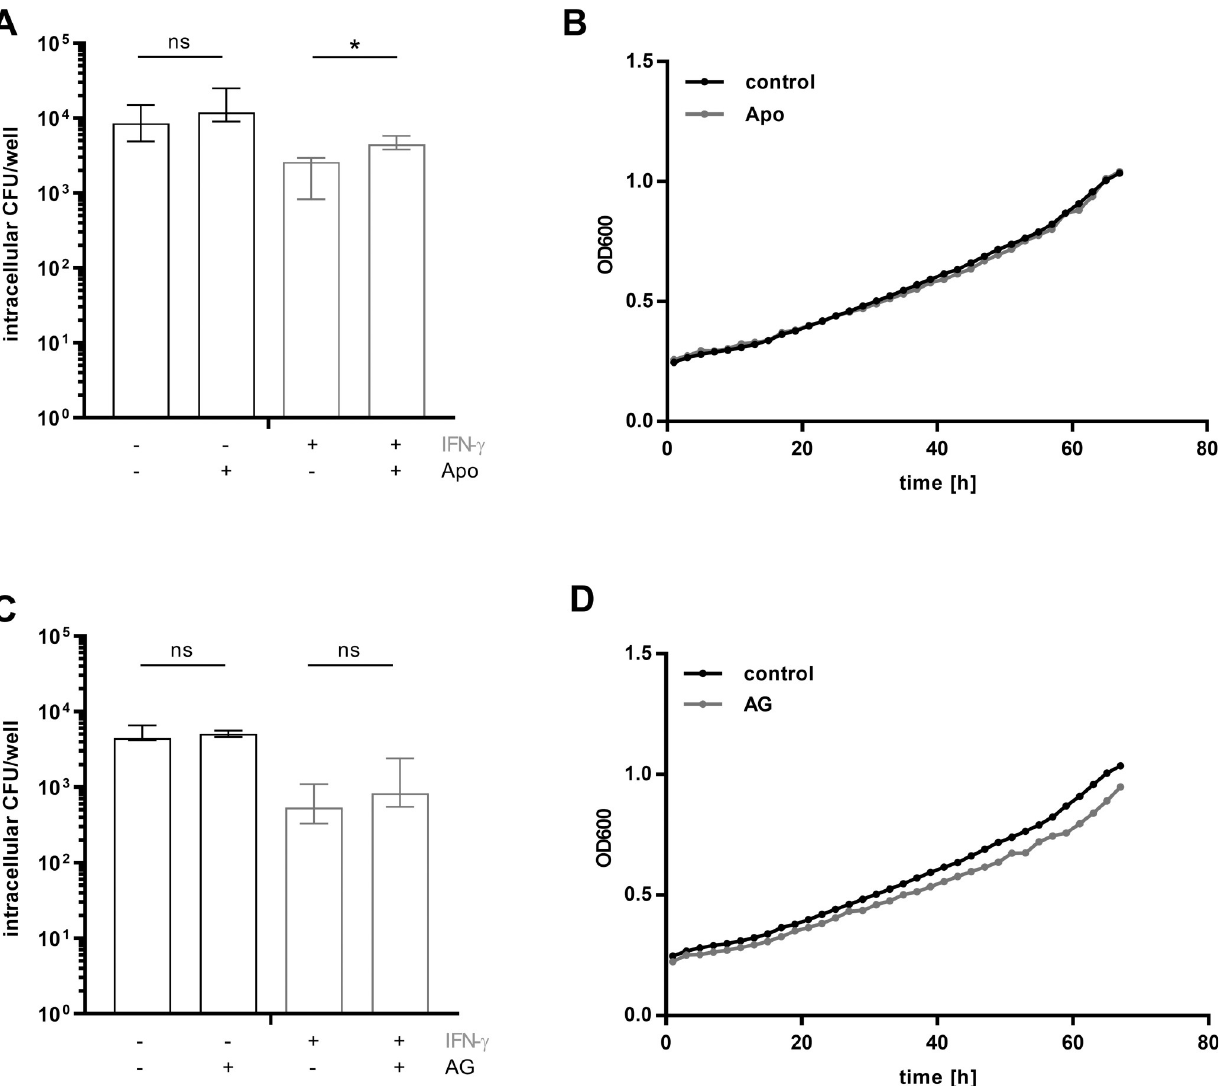
Fig 5. The antimicrobial effect of IFN- γ is mediated by the production of ROS. hMDMs were incubated with 500 μ M IFN- γ and inhibitors of inducible NADPH oxidase (apocynin) (A) or nitric oxide synthase (aminoguanidine) (C) prior to and during the infection with B . pseudomallei (MOI 300). The intracellular bacterial burden was determined 6h p.i. Data are expressed as median with interquartile range of � 3 independent experiments with different donors. All experiments were performed in technical duplicates. ( � p < 0.05) To determine an effect of the corresponding inhibitors on B . pseudomallei , growth curves were performed in control medium and medium containing Apo (B) or AG (D). Shown are mean values of 3 independent experiments performed in duplicates. Apo (apocynin), AG (aminoguanidine), p.i. (post infection), h (hours), ns (not